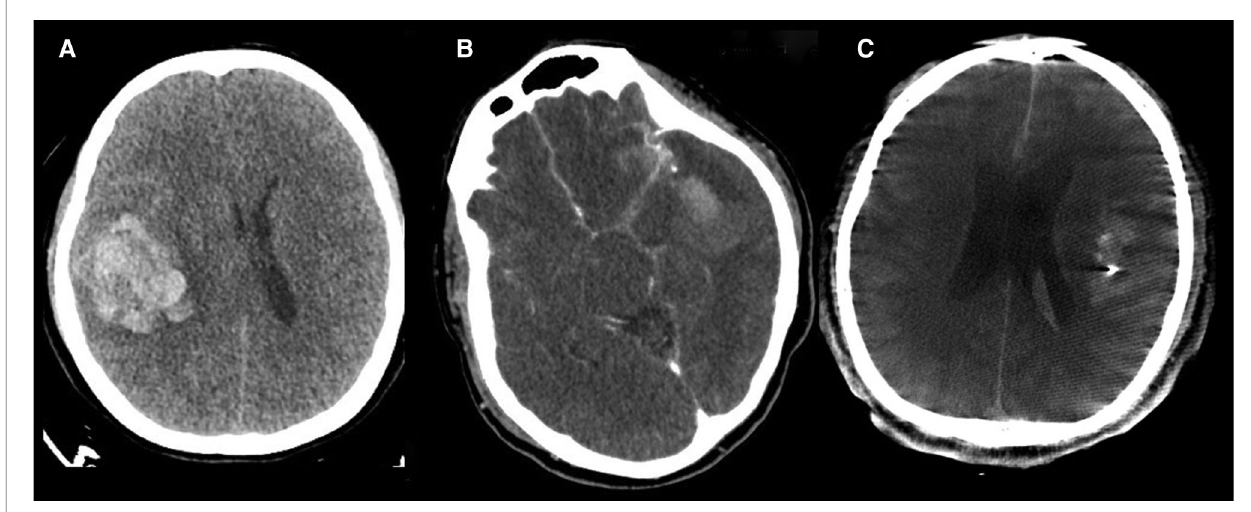
FIGURE 1 | Image parameters documented on the initial brain CTA. ( A ) Distal hematoma. ( B ) Perisylvian low density. ( C ) CTA spot